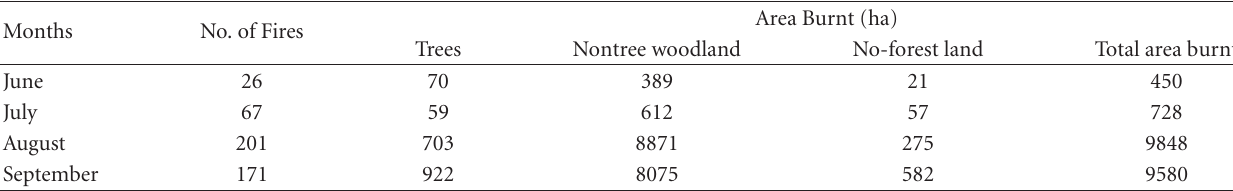
Table 3: Number of fires per month and monthly surface burnt according to the type of vegetation a ff ected (trees, nontree woodland, or no-forest land). Total land area a ff ected during the summer of 2000.